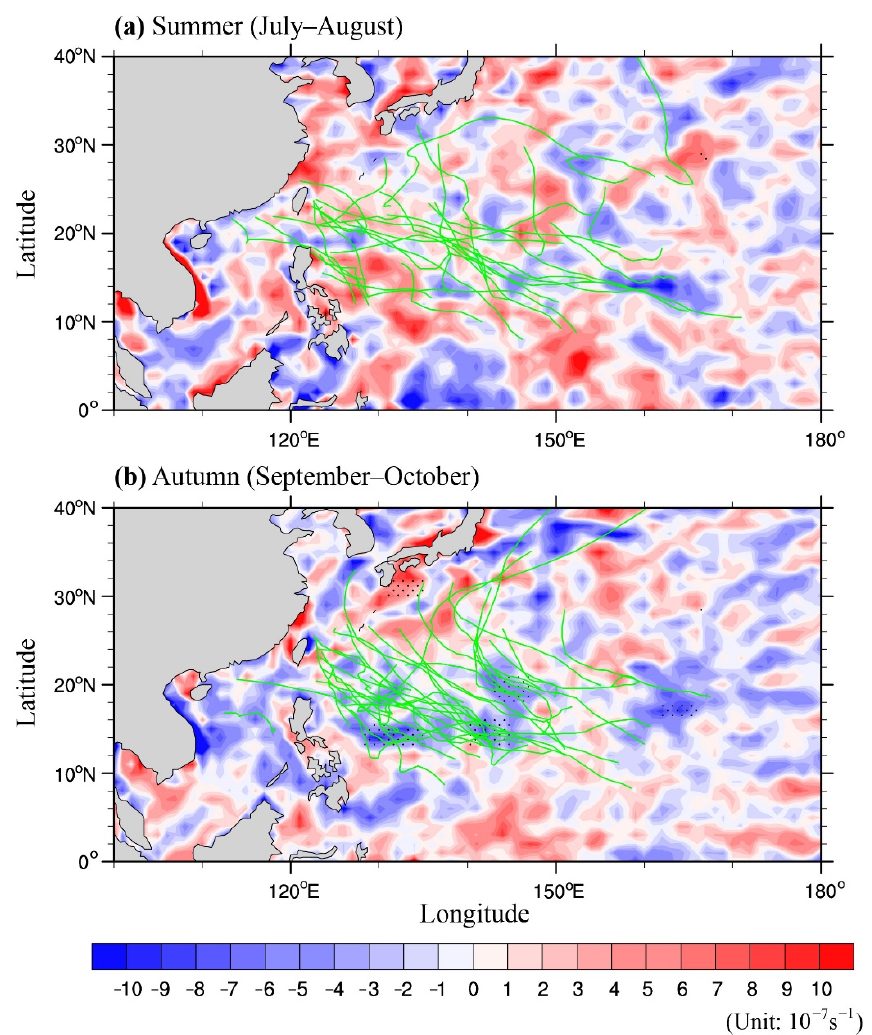
Figure 7. Difference of composite divergence (shading; unit: 10 − 7 s − 1 ) between VOR TCs and Environmental TCs at 850 hPa. Dots indicate areas of >90% confidence level according to the Student’s t -test. The green lines indicate the tracks of VOR TCs during their intensification period: ( a ) TCs in summer (July–August) and ( b ) TCs in autumn (September–October).